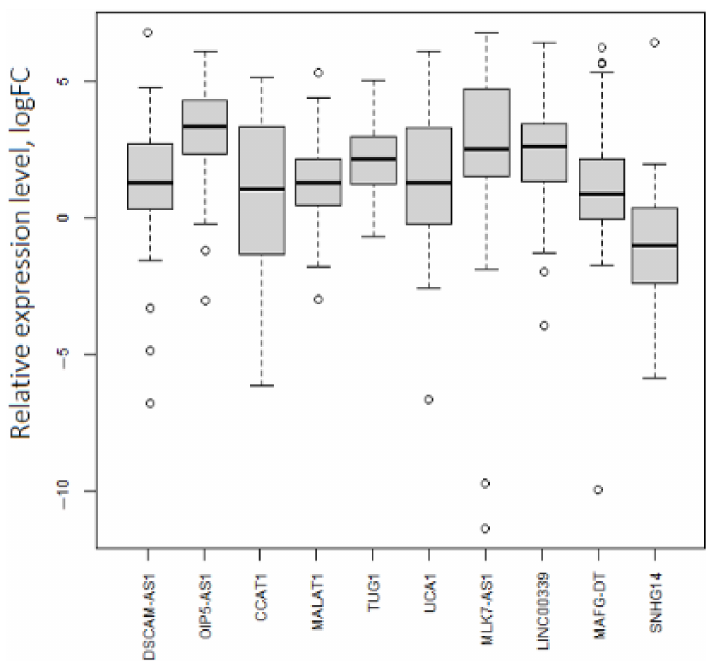
Figure 3. Expression levels of 10 lncRNAs in OC. p .adj < 0.05 for each